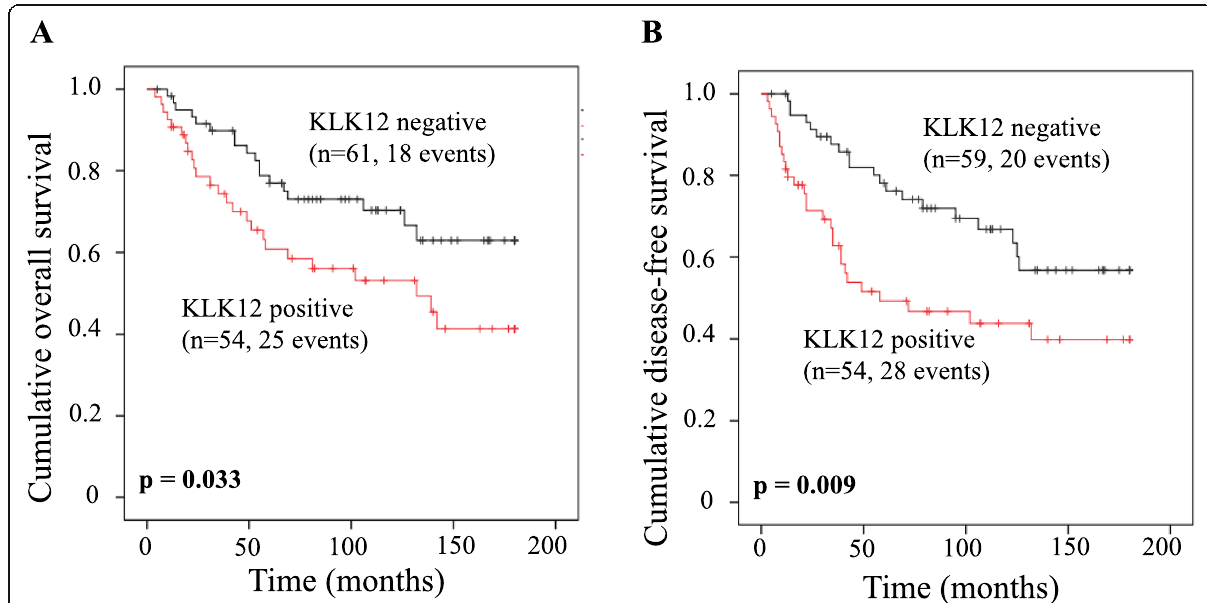
Fig. 1 Overall survival (OS) and disease-free survival (DFS) of patients with triple-negative breast cancer according to KLK12 mRNA expression in primary tumor tissues. Patients with positive KLK12 mRNA expression had a significantly shortened OS ( a ) and DFS ( b ) than those with negative KLK12 mRNA expression ( p = 0.033 and p = 0.009, respectively). Survival curves were drawn according to the Kaplan-Meier survival analysis. P values were calculated via the log-rank